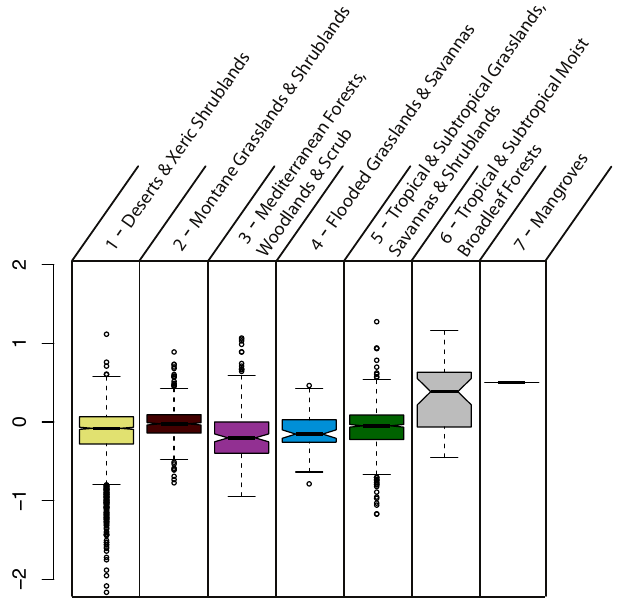
Figure 8. Box plots representing the dispersion of the normalized anomalies (Eq. 13) for each biome. There is more dispersion within each biome (length of the boxes) than between, confirming the re- sults of the between-groups PCA (90% of variance not explained by the